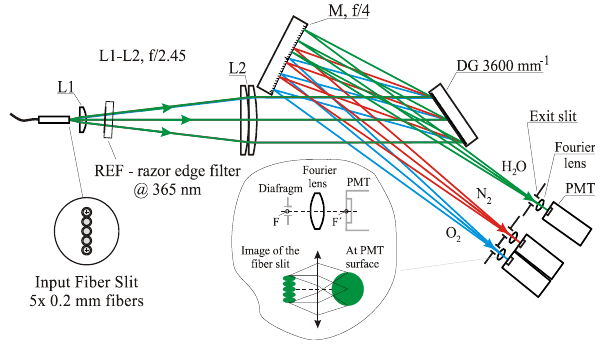
Fig. 8. Minimum values of the relative variations of f H R σ π (λ,T )I x H (λ) d λ as a function of the water vapor chan- H 2 O 2 O nel FWHM bandwidth for the temperature range − 60°C + 40°C.